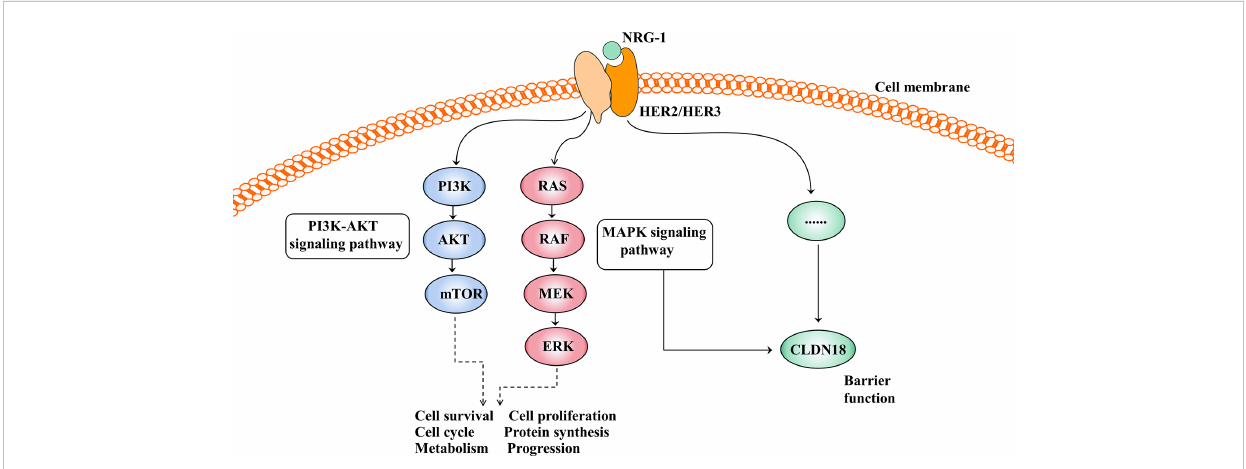
FIGURE 4 Activation of the HER2/HER3 signalling pathway and its effect after activation. The PI3K-AKT and MAPK signalling pathways are the two main signal transduction pathways downstream of HER2/3 heterodimerisation activation and are involved in cell growth, cell proliferation, the cell cycle, protein synthesis and so on. In addition, the HER2/HER3 signalling pathway regulates barrier function by regulating the expression of CLDN18, but the mechanism is